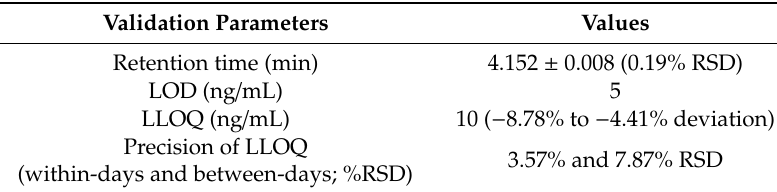
Table 3. Recovery (%) of sesamol in methanol and cell lysate ( n = 8). QC: quality control. Concentration (ng/mL)